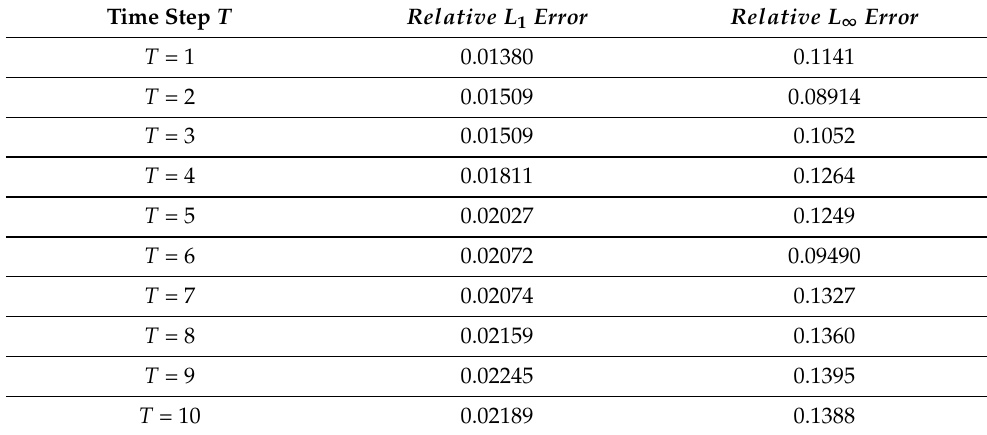
Table 3. The Relative L 1 Error and Relative L ∞ Error of the LSTM model at different time steps T .